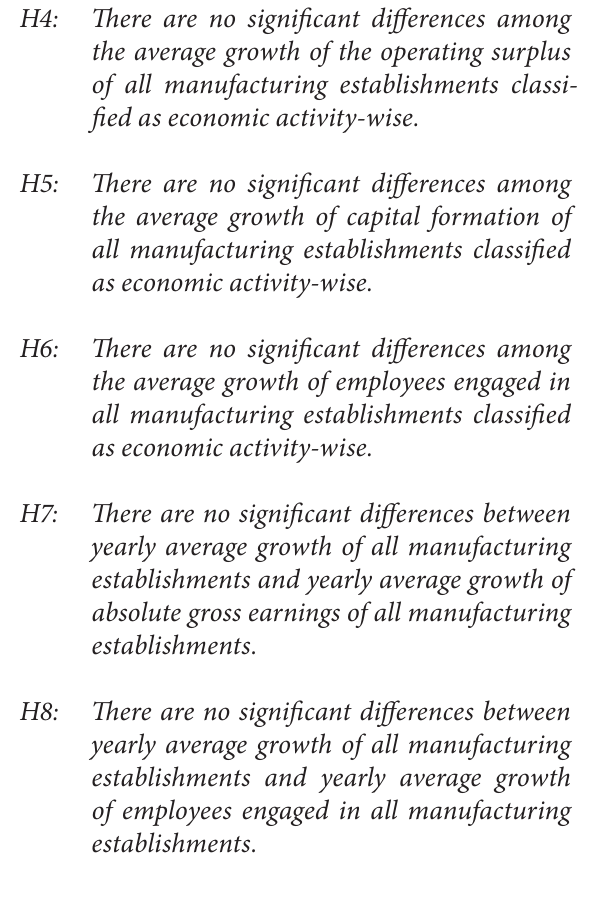
Table 1. Yearly growth movement analysis of all industries of the manufacturing sector of Saudi Arabia Statistical